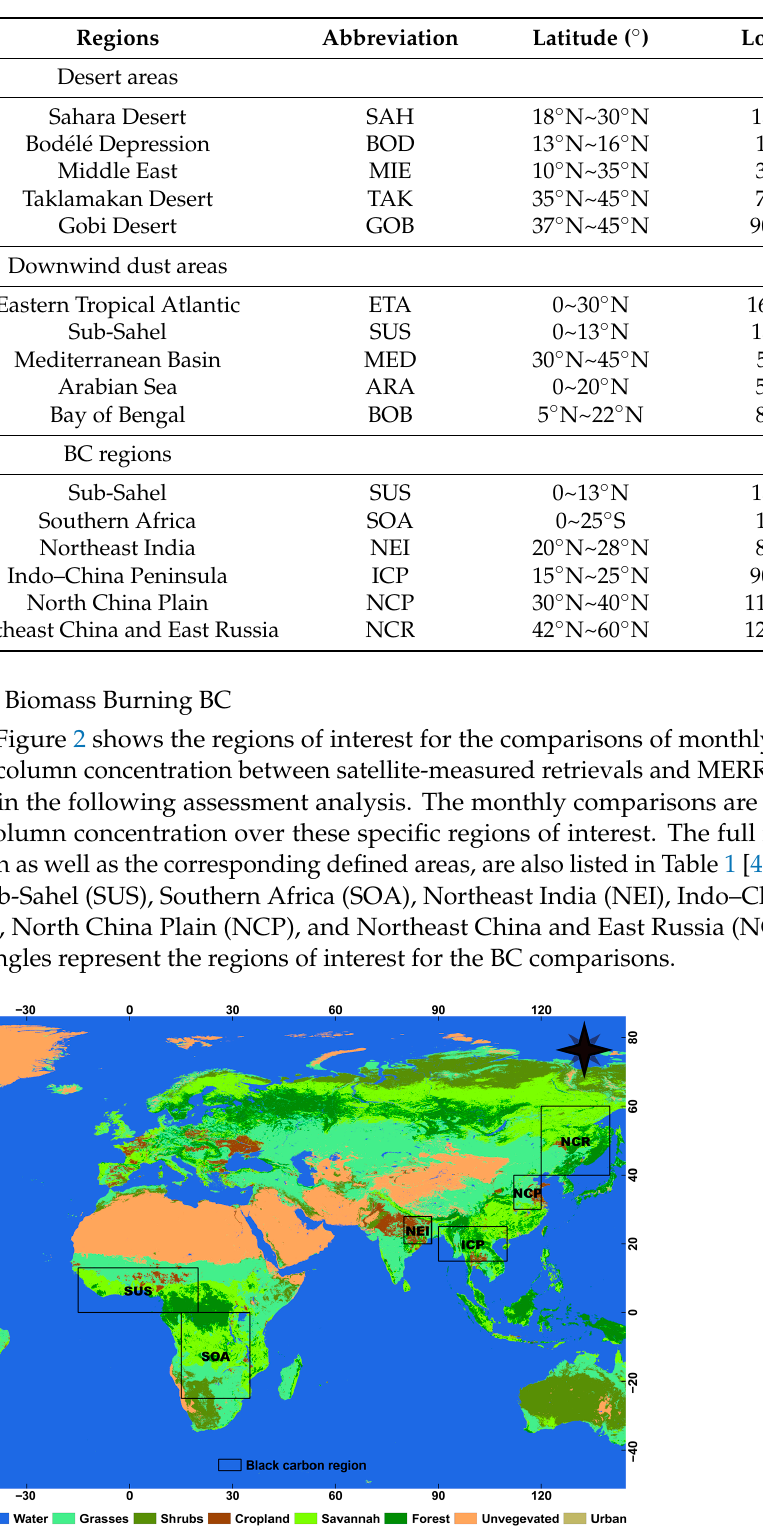
Table 1. Comparison of the mineral dust and BC column concentration between MERRA-2 data and GRASP component retrievals over several key regions of interest globally [42,43].